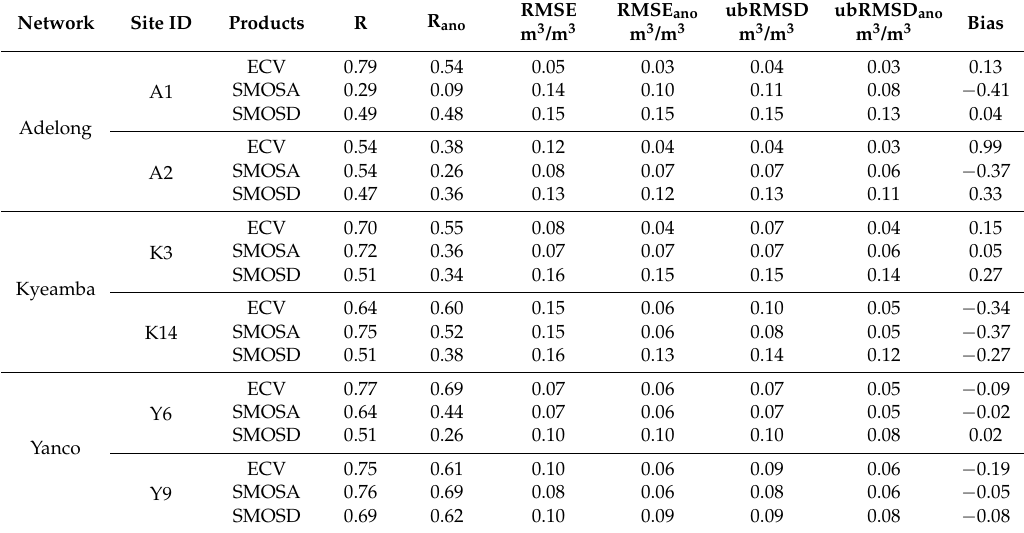
Table 2. The error metrics of different soil moisture products at the selected